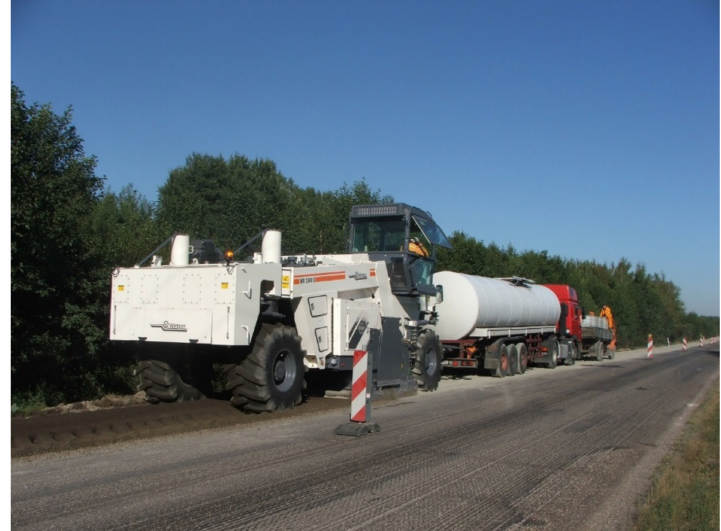
Figure 1. Manufacturing of the bitumen emulsion (MCE) mixture using the “in-place” method. [J.